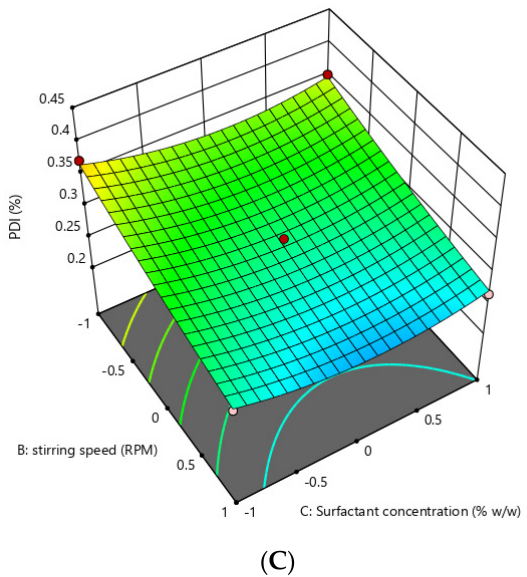
10 of 24 Figure 4. Contour graph showing effect of independent variables on PDI (Y2). ( A ) effect of oil con- centration and stirring speed on PDI. ( B ) surfactants concentration and oil concentration on PDI. ( C ) effect of stirring speed and surfactant concentration on PDI.